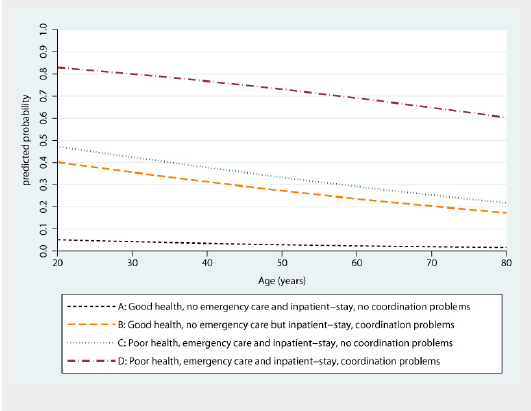
Predicted probability for any patient-reported error for four hypothetical patients (A-D), weighted